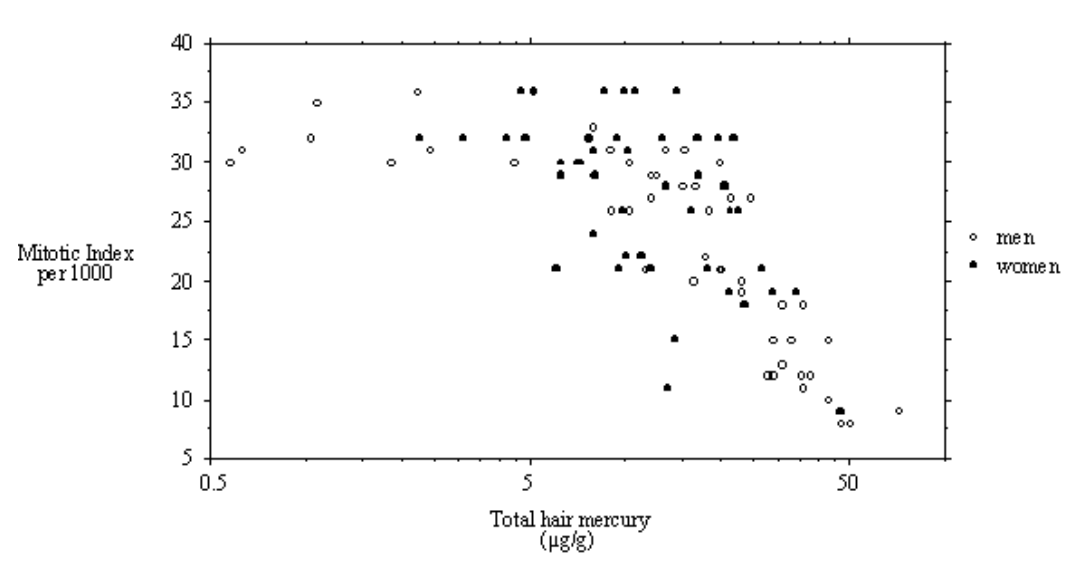
Fig. 1 – Relation between mitotic index for men and woman with respect to total hair mercury.